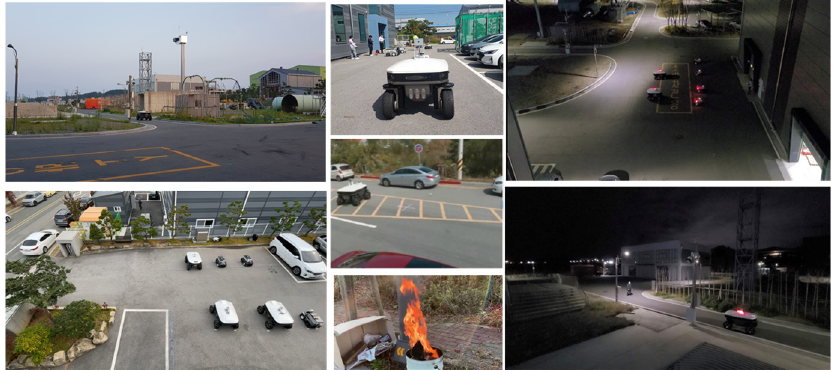
Figure 19. Multi-modal sensor module based 6 mobile agents-based day/night surveillance system test include abnormal situations (e.g., fire, illegal parking, and intruders).